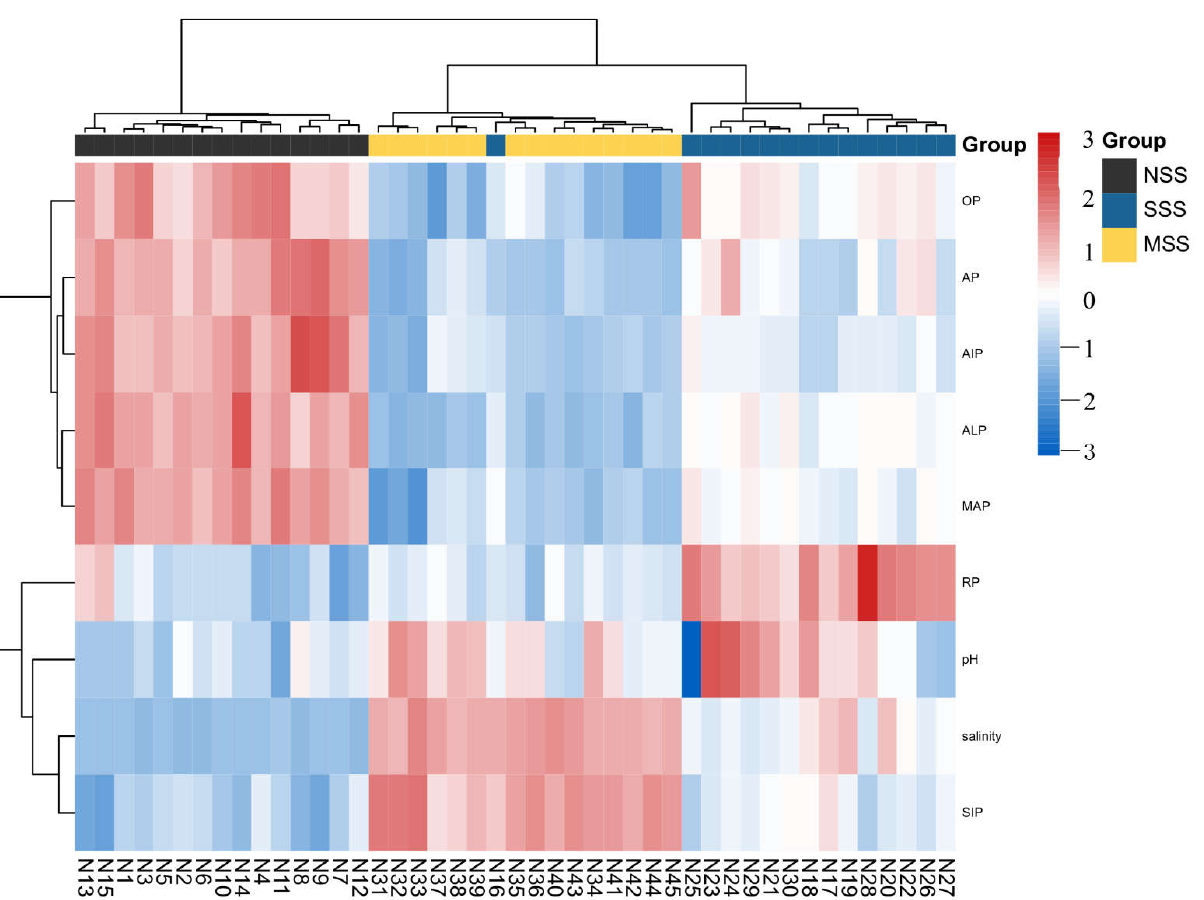
Figure 10. Heat map of relative impact factors in different degree of saline soil. Note: The clustering heatmap represented values of impact factors in different degree of saline soil, and data of different indicators are normalized due to the range of different measured values of indicators.